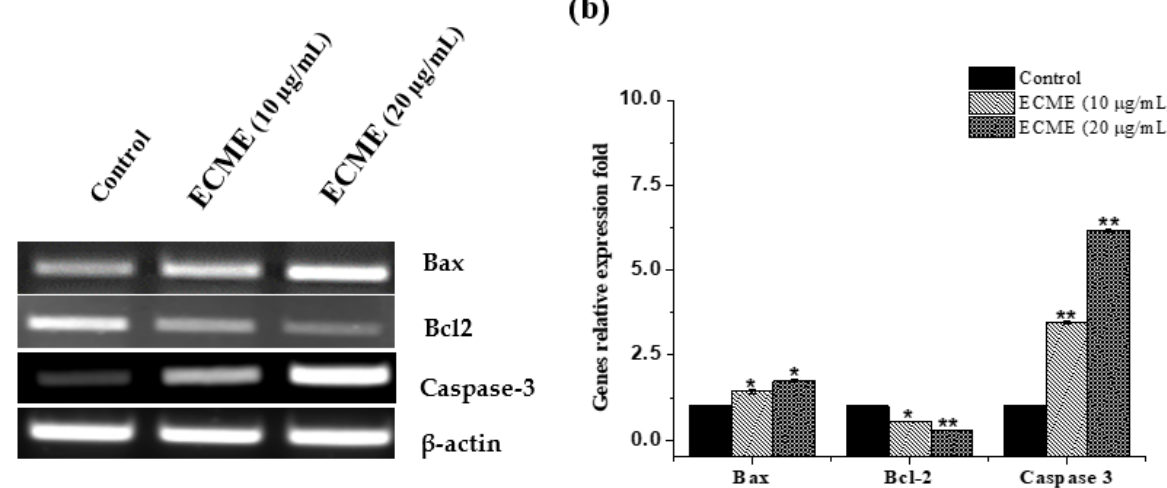
Figure 5. Effects of ECME on the expression levels of Bax, Bcl-2 and caspase 3 genes determined via RT-PCR analysis. A549 cells were exposed to ECME at two effective concentrations of ECME for 48 h, while the negative control was treated with DMSO (0.01%). ( a ) The expression of apoptosis-related genes, including Bax, Bcl-2 and caspase-3 were detected by RT-PCR and β -actin was employed as internal a reference. ( b ) The quantitative level is display in histograms and the average value (n = 3), for the control was set at one. * p < 0.05, ** p < 0.01 vs. the control group.